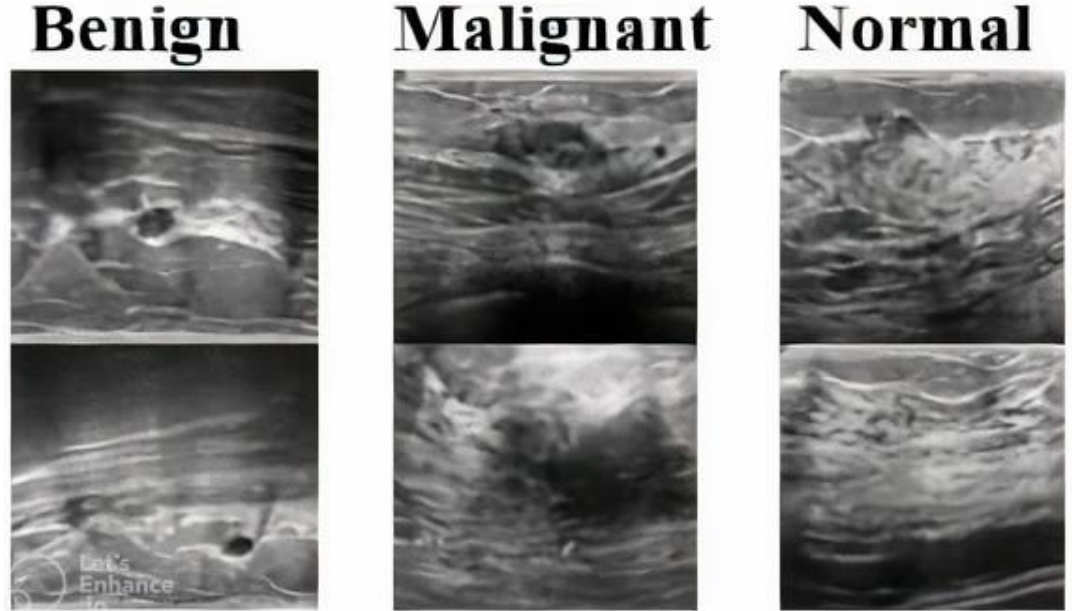
Figure 1. All images are 500 × 500 pixels in size and in PNG format. The dataset in [47] con- tains 250 BC images, 100 benign and 150 malignant (https://data.mendeley.com/datasets/ wmy84gzngw/1 (19 January 2023)). The details of BC datasets are presented in Table 1.